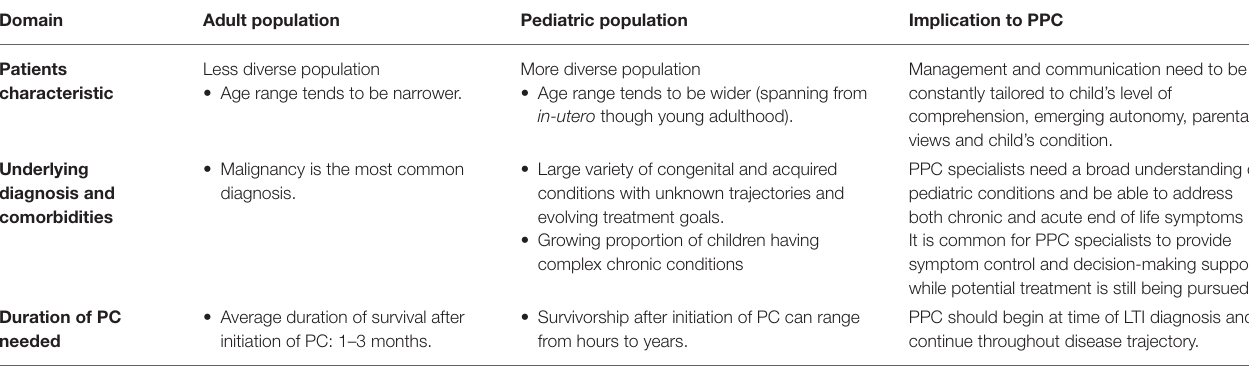
TABLE 1 | Differences between adult and pediatric palliative